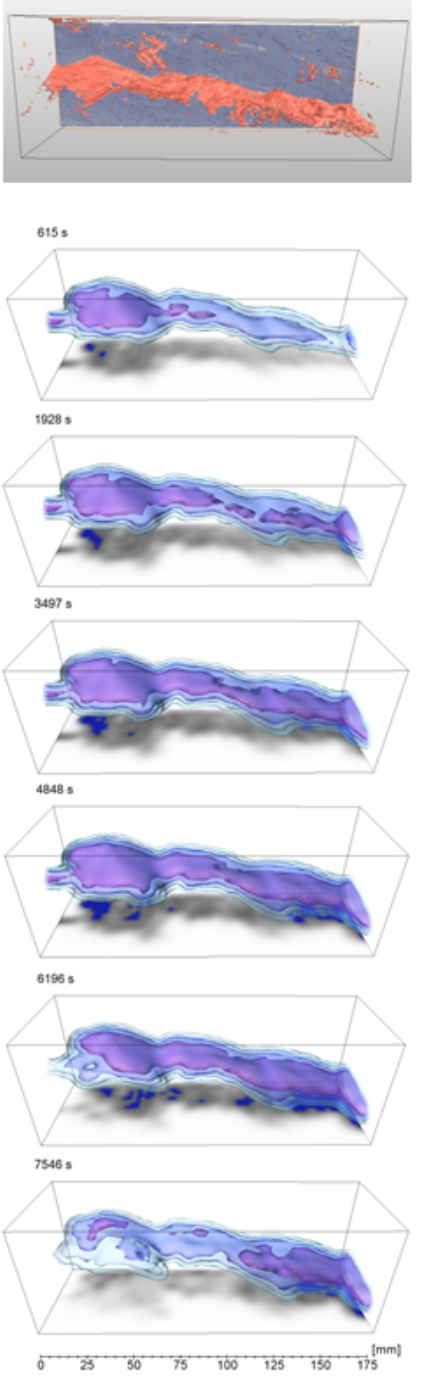
Figure 6. Top: µ-CT image of a granite core with a single fracture (recorded at the Federal Institute for Material Research and Testing BAM, Berlin, and processed by F. Enzmann, Johannes Gutenberg University, Mainz). Below: six PET frames recorded with a clinical PET scanner at the Clinic and Polyclinic for Nuclear Medicine of Leipzig University Hospital.